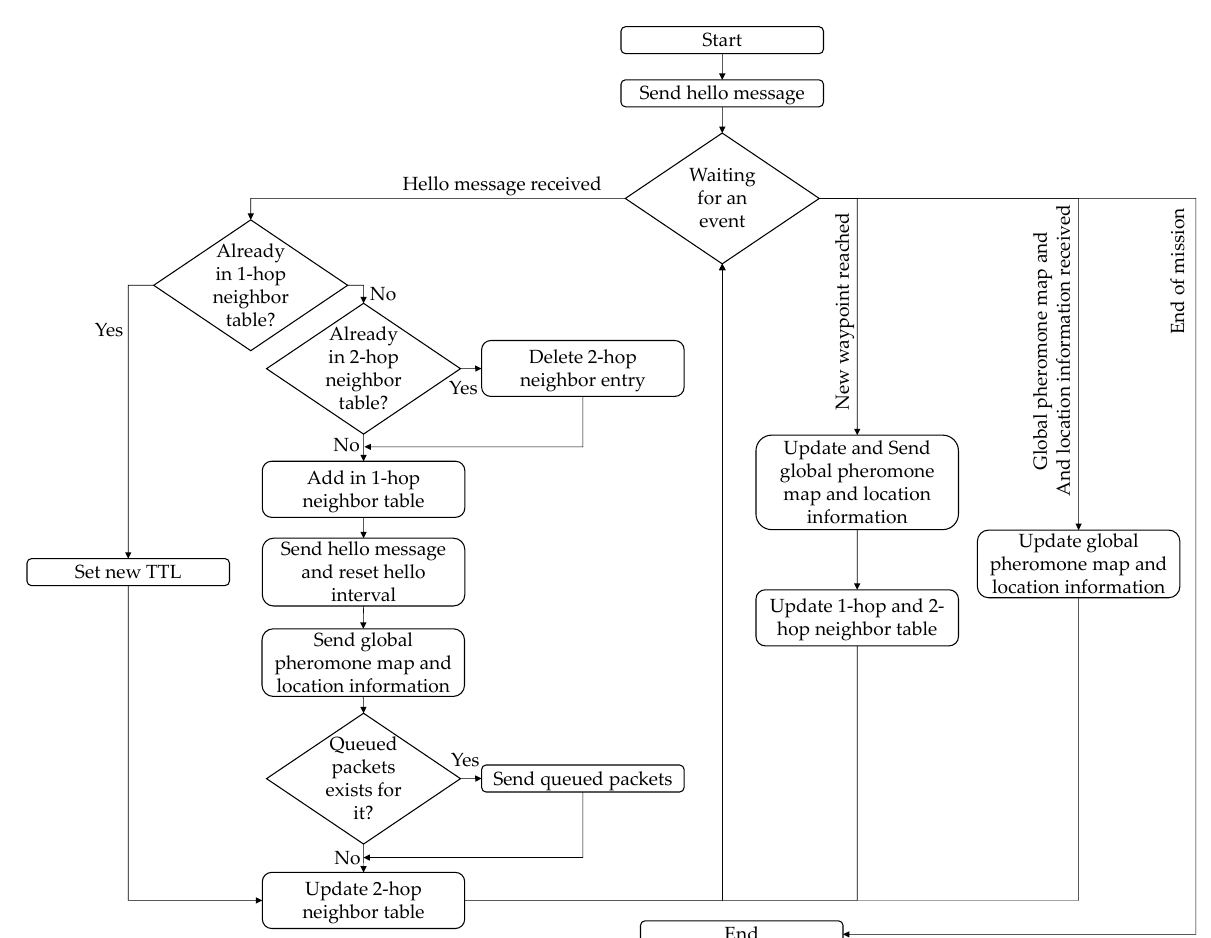
Figure 9. Flowchart with the update mechanism of the one ‐ and two ‐ hop neighbor data tables.